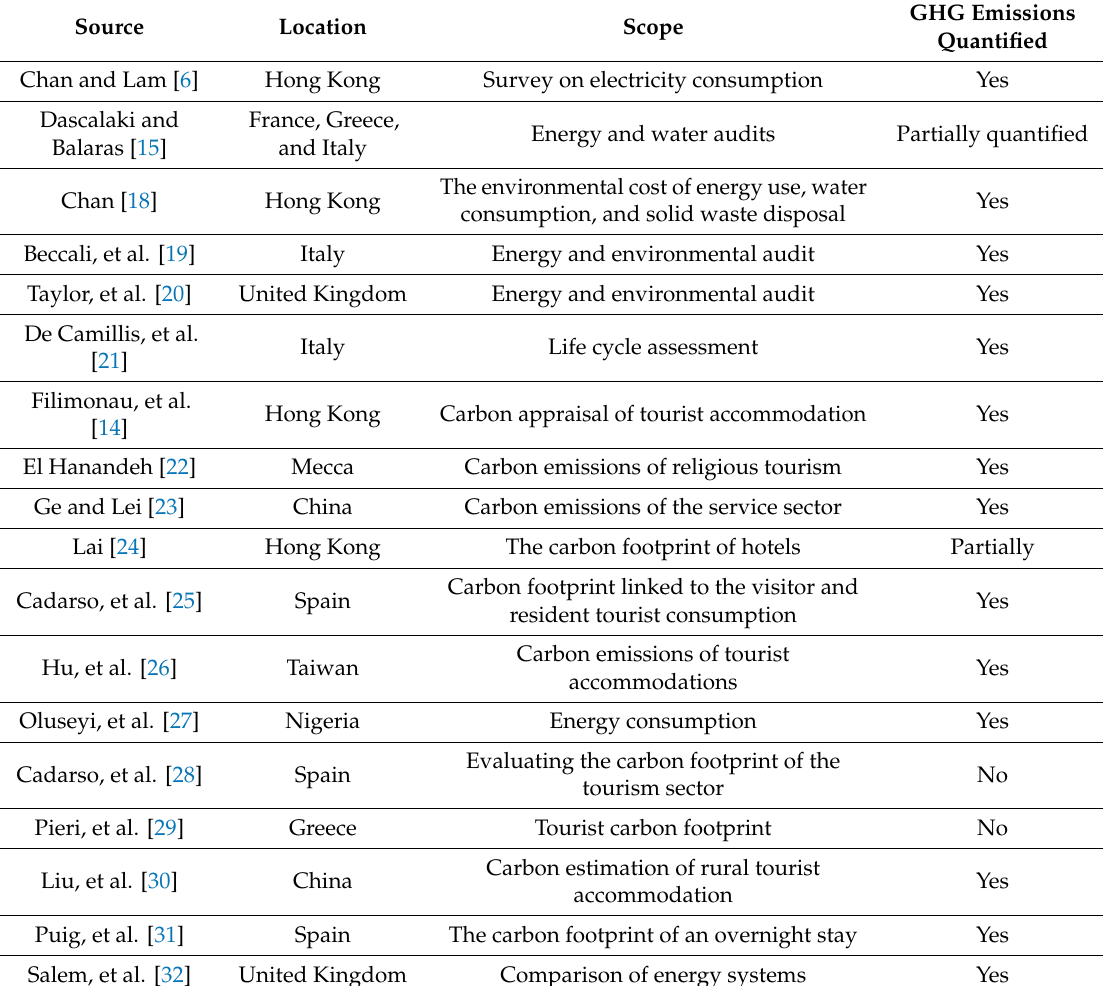
Table 1. Tourist accommodation-related studies on carbon